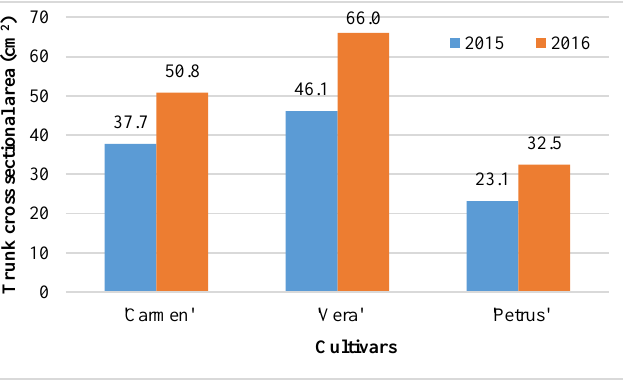
Figure 3. Trunk cross sectional area at Spanish bush canopy in 10 cm high (Debrecen-Pallag,